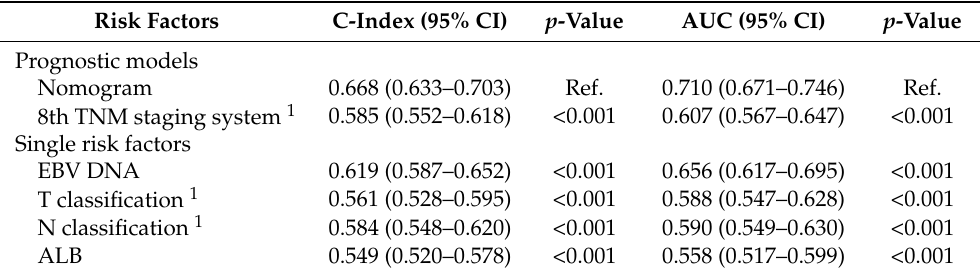
Table 2. C-index and AUC of prognostic model and single risk factors for predicting DFS in elderly patients with